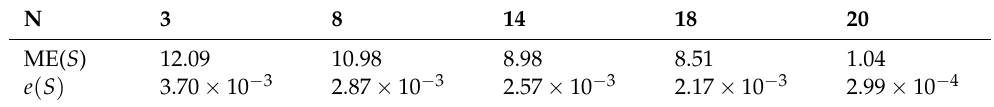
Table 3. For example 7, the influence of mesh parameter N on ME( S ) and e ( S ) .